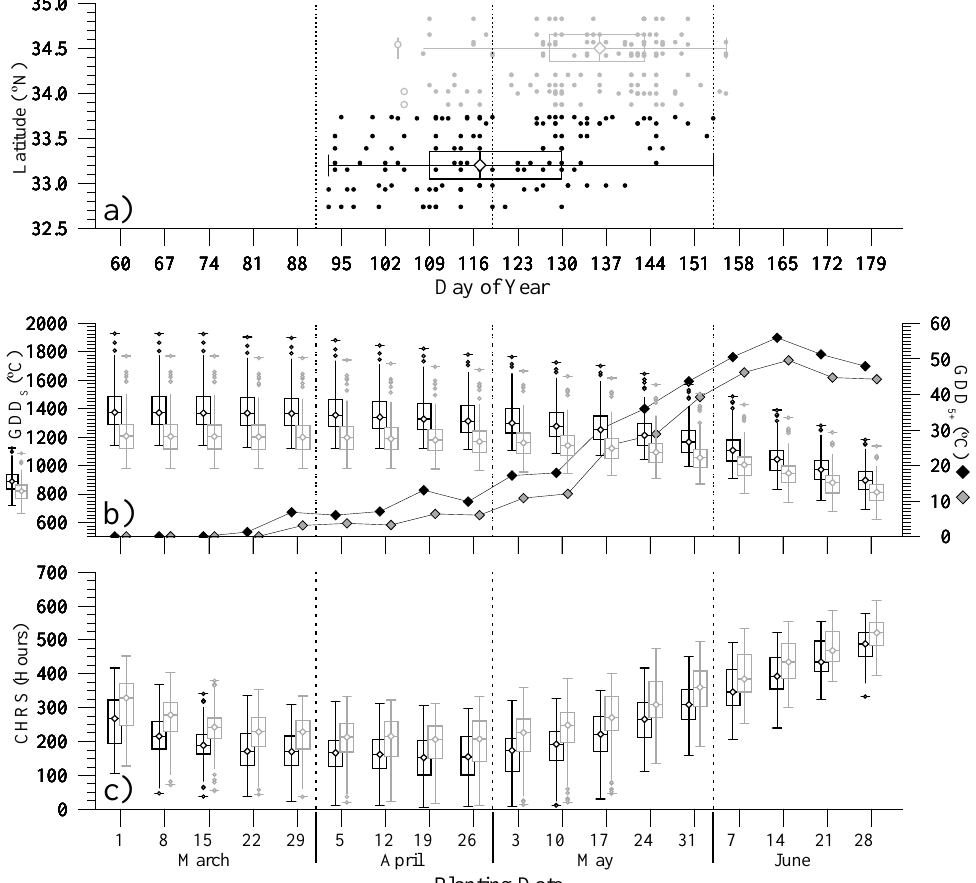
Figure 8. ( a ) Scatterplots of Figure 1 station latitudes (X-axis) vs. first day of year (pdoy f ) Sansone et al. [41] soil temperature and GDD 5 + planting conditions were met during each year of 2005-2017 (Y-axis). Gray (black) points show scatter of Figure 1’s 11(10) northernmost (southernmost) stations. Gray (black) bar plots mark percentiles of northern (southern) pdoy f values. ( b ) Gray (black) bar plots showing the percentiles of GDD S (Equation (1)) calculated between 18 planting dates and Oct. 15 during 2005–2017 over Figure 1’s northern (southern) WTM stations. Gray (black) diamonds show medians of northern (southern) growing degree days accumulated in the 5 day period after each planting date (GDD 5 + ) ( c ) Gray (black) bar plots showing the percentiles of cooling hours (CHRS: Equation (2)) accumulated 80 to 110 days after 18 planting dates during 2005 – 2017 over Figure 1’s northern (southern) WTM stations.